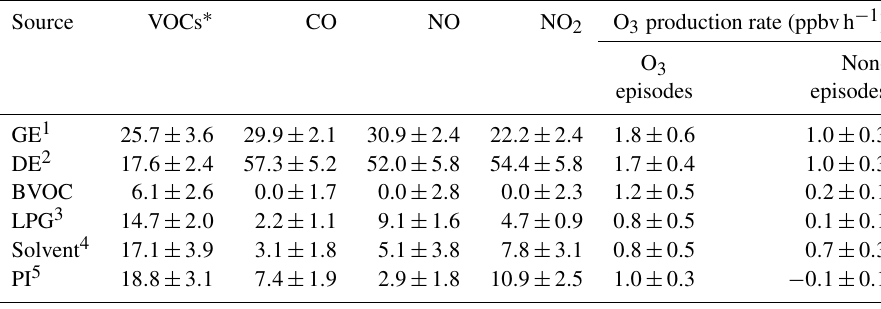
Table 2. Contributions to VOCs, CO, NO, NO 2 and the O 3 production rate by the sources of O 3 precursors averaged on the VOC sampling days in Jinan (Unit: % unless otherwise